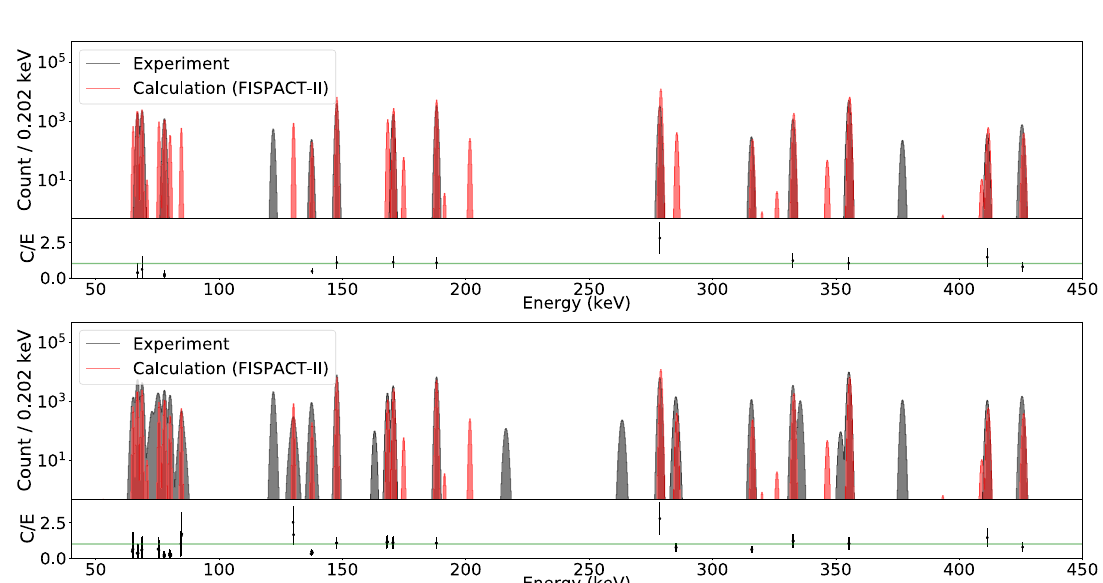
Figure 6: The comparison of FISPACT-II simulated gamma lines (red) to experimental gamma lines (black) following peak identification, background subtraction and Gaussian broadening using a sliding window approach (top) and a neural network (bottom) for peak identification, in the reduced energy range 50 keV to 450